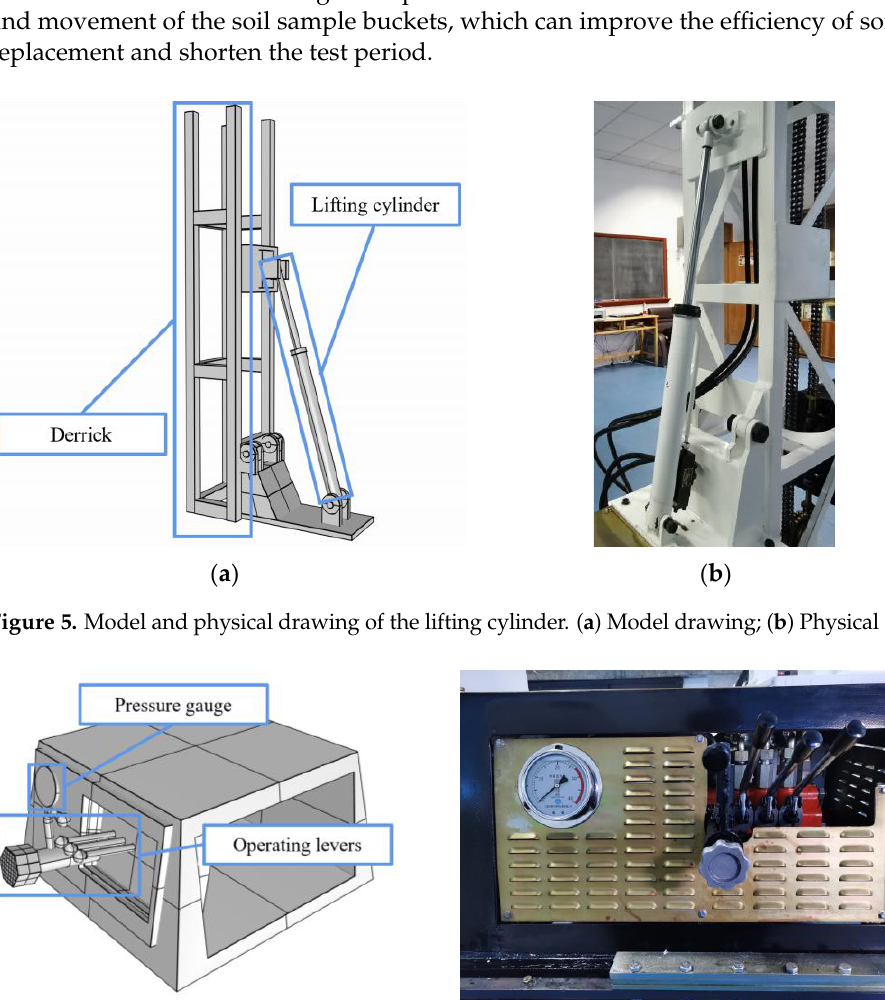
Figure 6. Model and physical drawing of the console. ( a ) Model drawing; ( b ) Physical drawing.